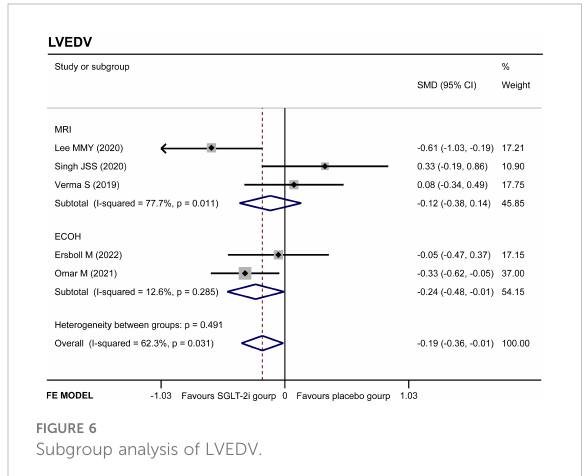
FIGURE 6 Subgroup analysis of